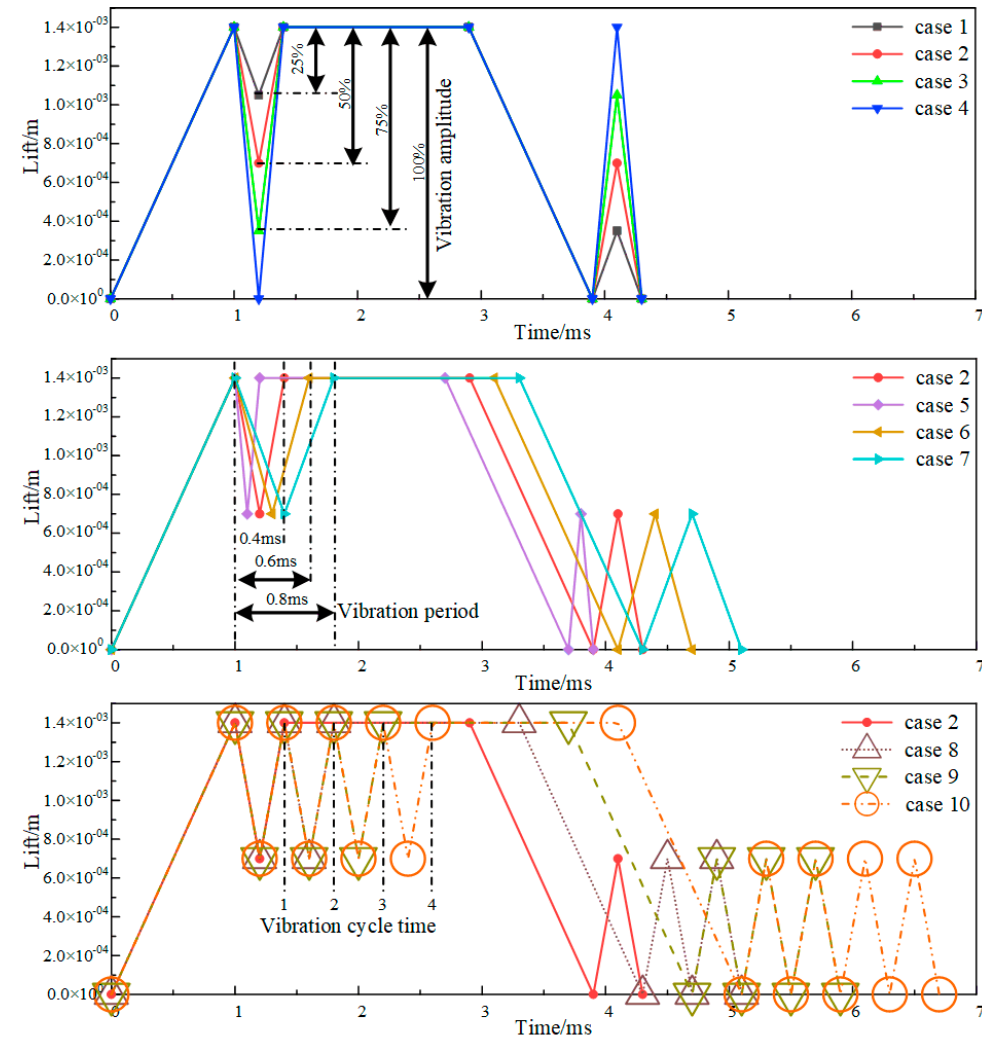
Figure 2. Lift curve of each case.